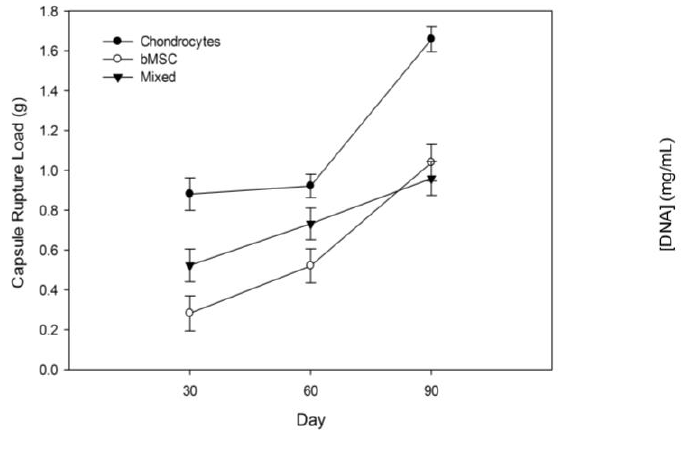
Figure 14. Quantitative measurements of the changes over the 90-day encapsulation culture to ( a ) the PECM rupture strength and ( b ) cellular DNA content. Error bars indicate the standard devia- tion.